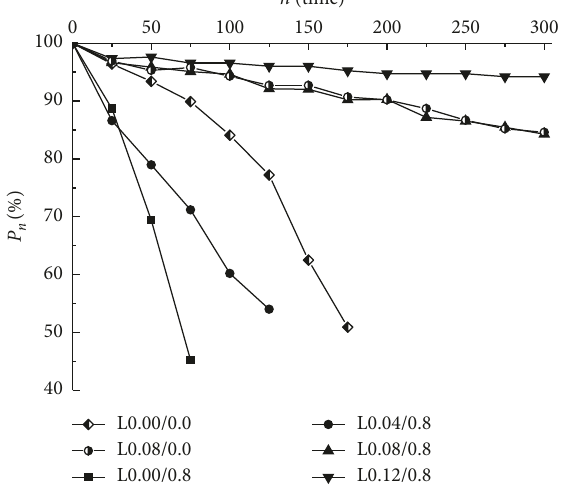
Figure 4: Changes of the relative dynamic modulus of elasticity affected by content of the air-entraining agent.